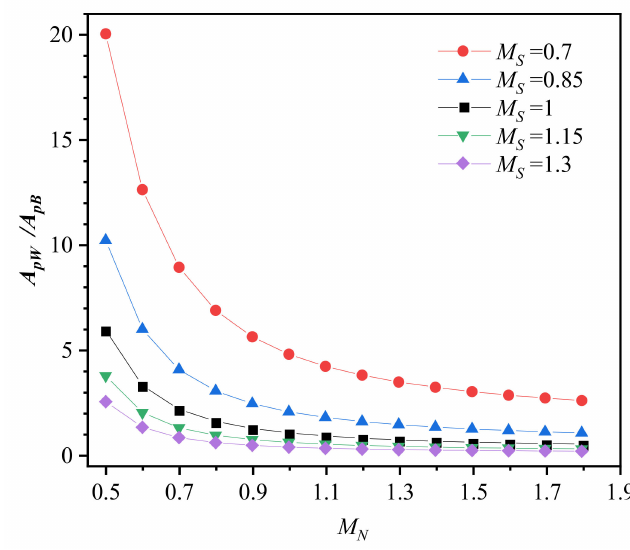
Figure 5. The ratio between plastic zone area of the weld metal and base